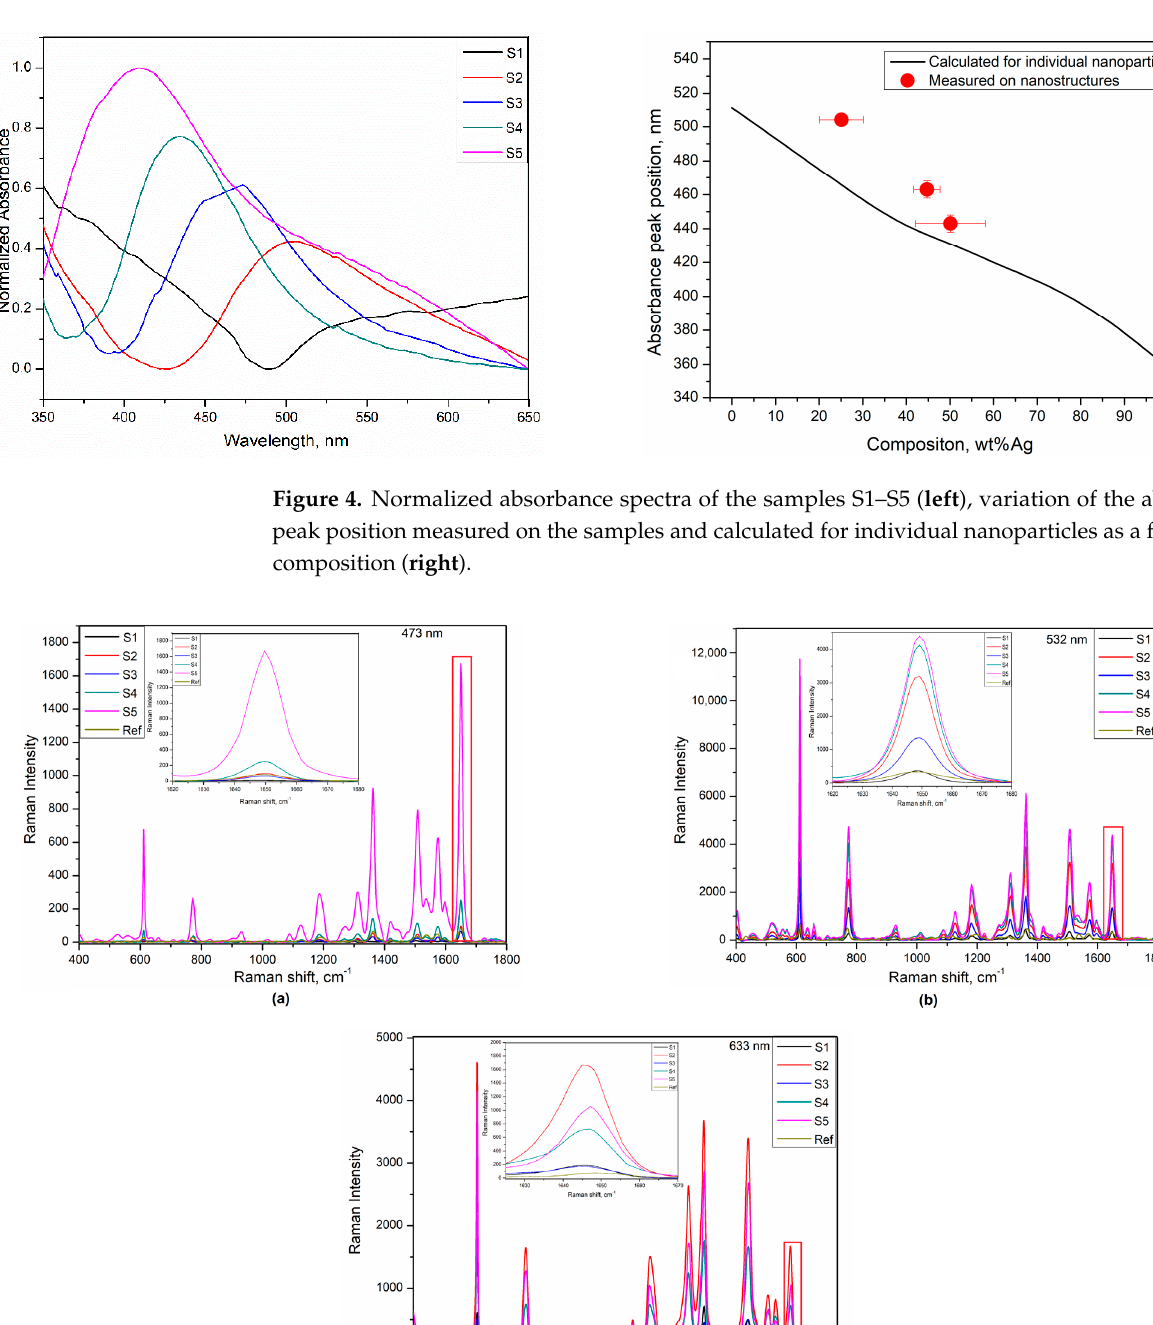
Table 4. EF values of S1–S5 were calculated for the ~1650 cm -1 peak at different excitation wavelengths.